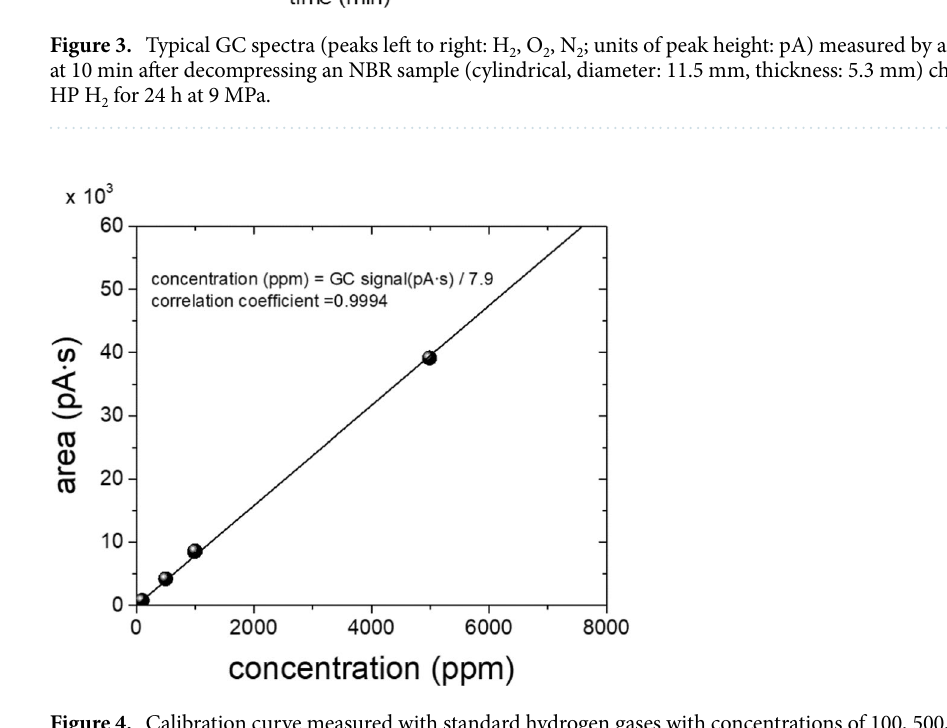
Figure 4. Calibration curve measured with standard hydrogen gases with concentrations of 100, 500, 1000, and 4989 ppm (balanced with helium